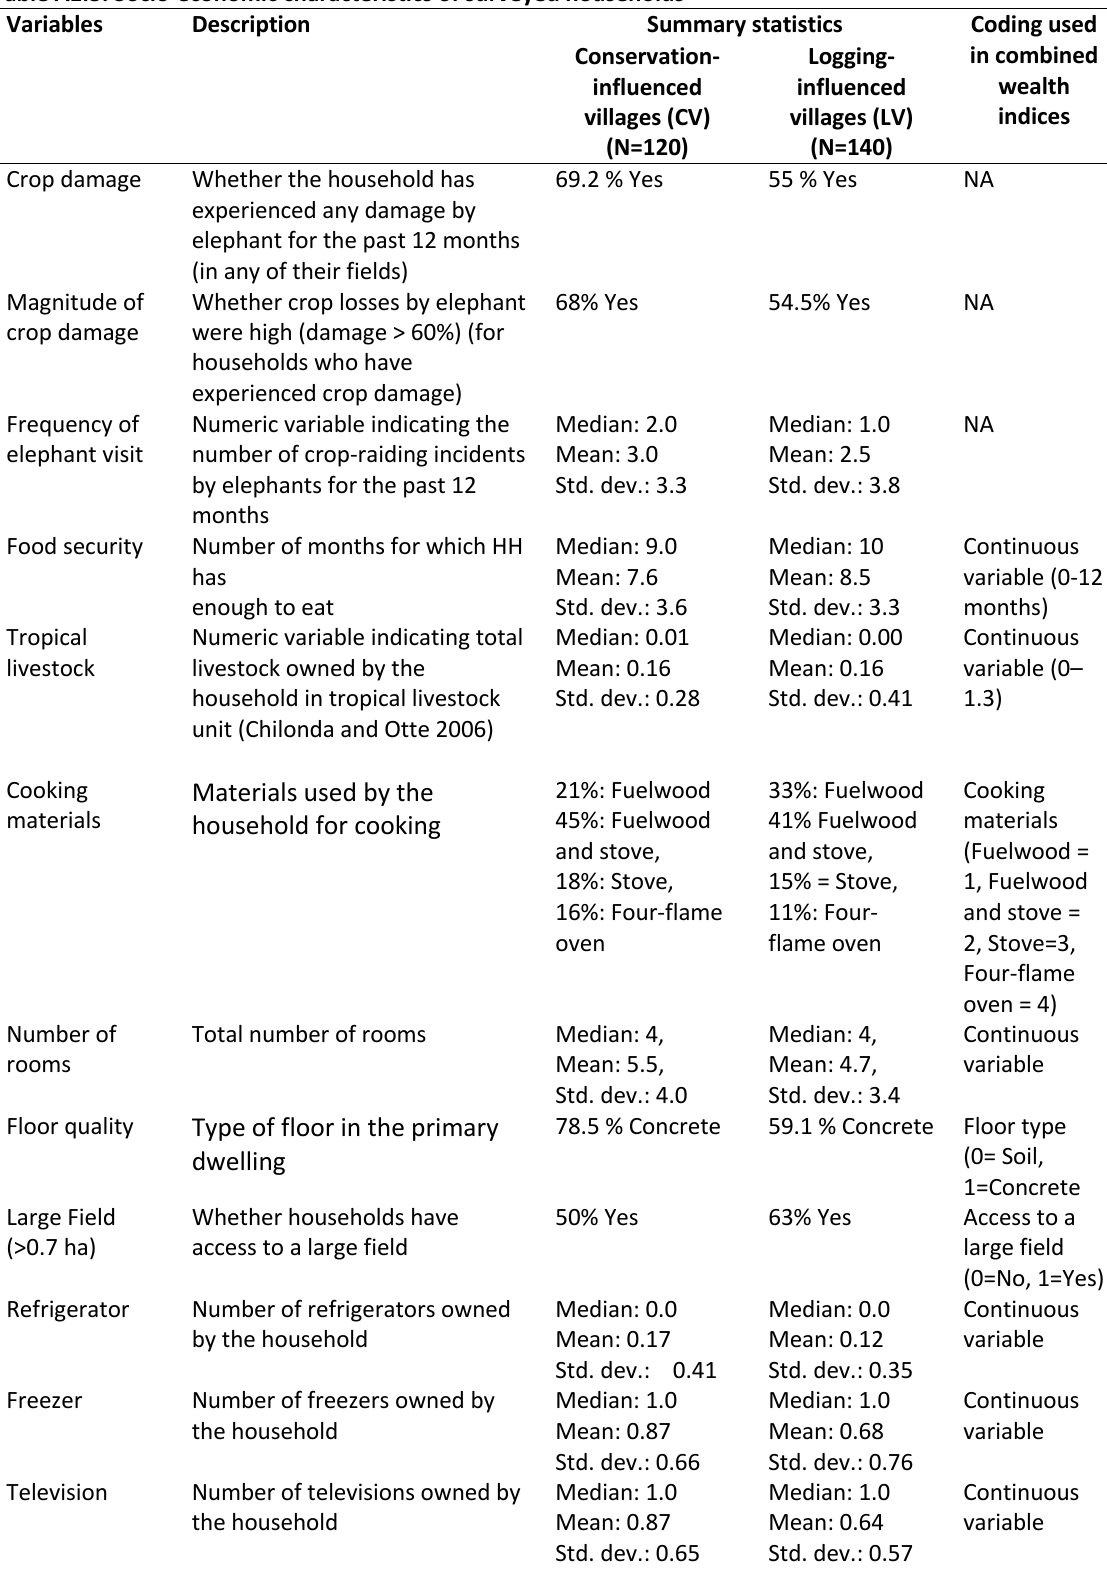
Table A1.3: Socio-economic characteristics of surveyed households